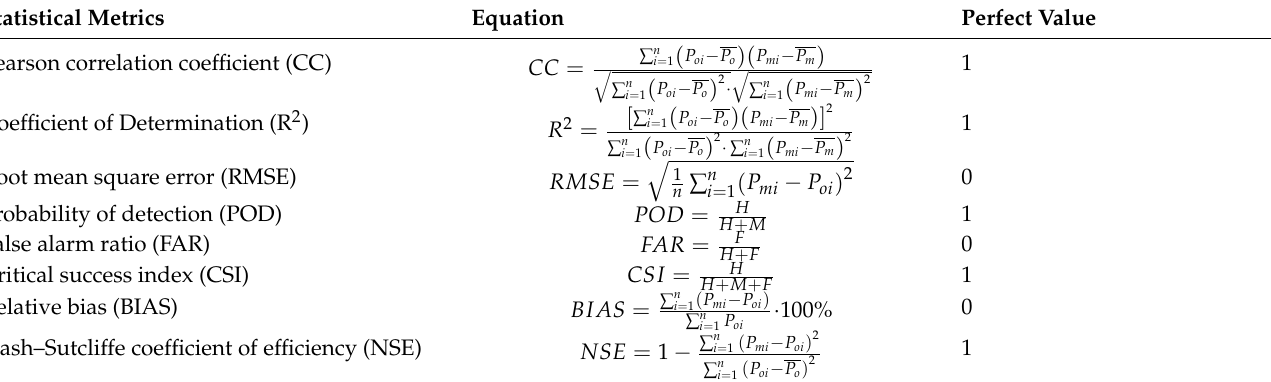
Table 2. The descriptions of statistical metrics used in this study for precipitation product and hydrological